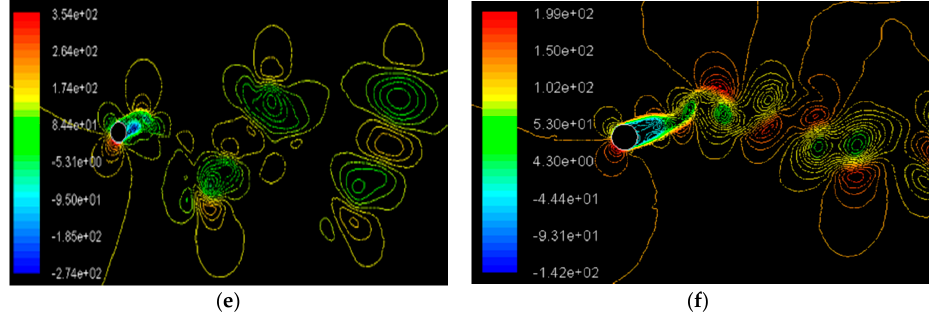
Figure 12. Representation of pressure (N/m 2 ) contours in 2P mode of vortex shedding for m* = 0.66 ( a ) U r = 4; ( b ) U r = 5; ( c ) U r = 6; ( d ) U r = 8; ( e ) U r = 10; ( f ) U r = 12. Table 4. Hydrodynamic and structural response characteristics for m* = 0.66, 1.32, and 1.98. Mass Ratio, m* U r C L Y/D f v (Hz) SheddingCharacteristics